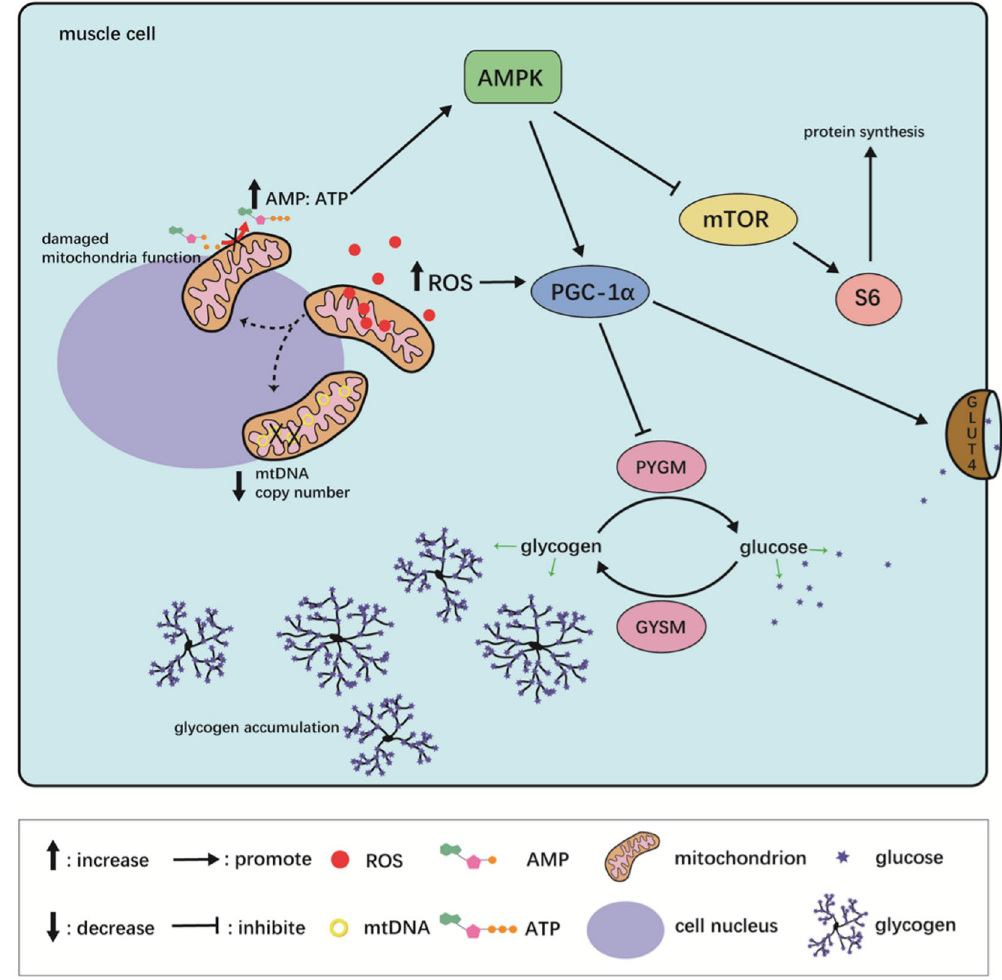
Figure 5. The summarized mechanism of the effect of high dietary carbohydrate level on muscle quality of olive